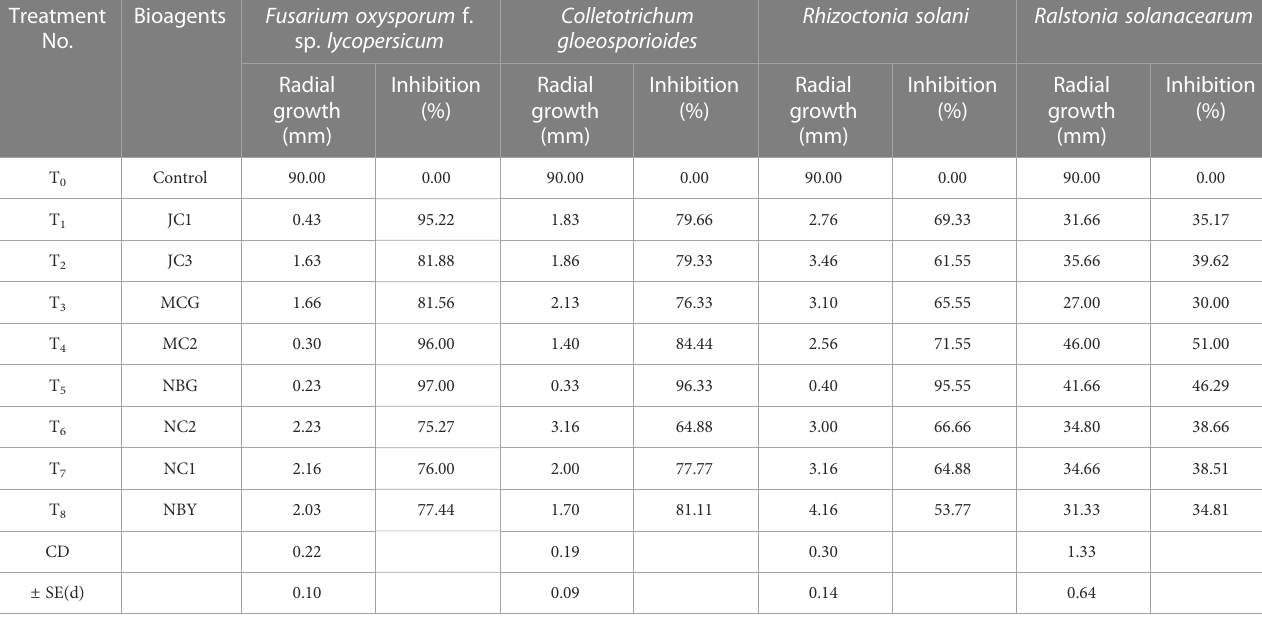
TABLE 5 Effect of non-volatile compound production of promising rhizospheric microbes on pathogens. Treatment